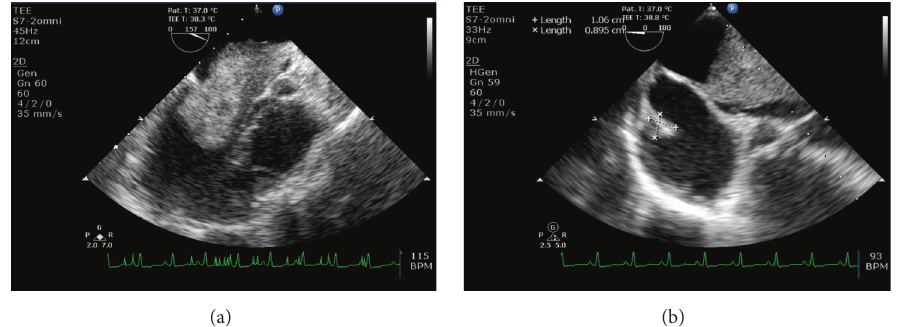
Figure 2: 2D transesophageal echocardiogram revealed (a) large left atrial mass of 6.6 × 3.1 cm size and (b) right atrial mass of 1 × 1cm size.